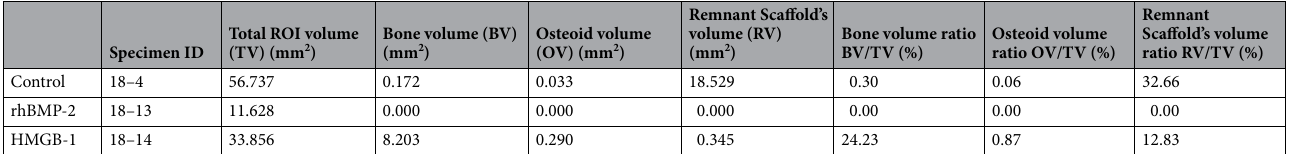
Table 2. Quantitative analysis of histological tissue images with Villanueva–Goldner staining specimens of each group. Representative histological tissue images from each group were quantitatively analyzed within the region of interest (ROI) presented in Fig. 4A,C, and